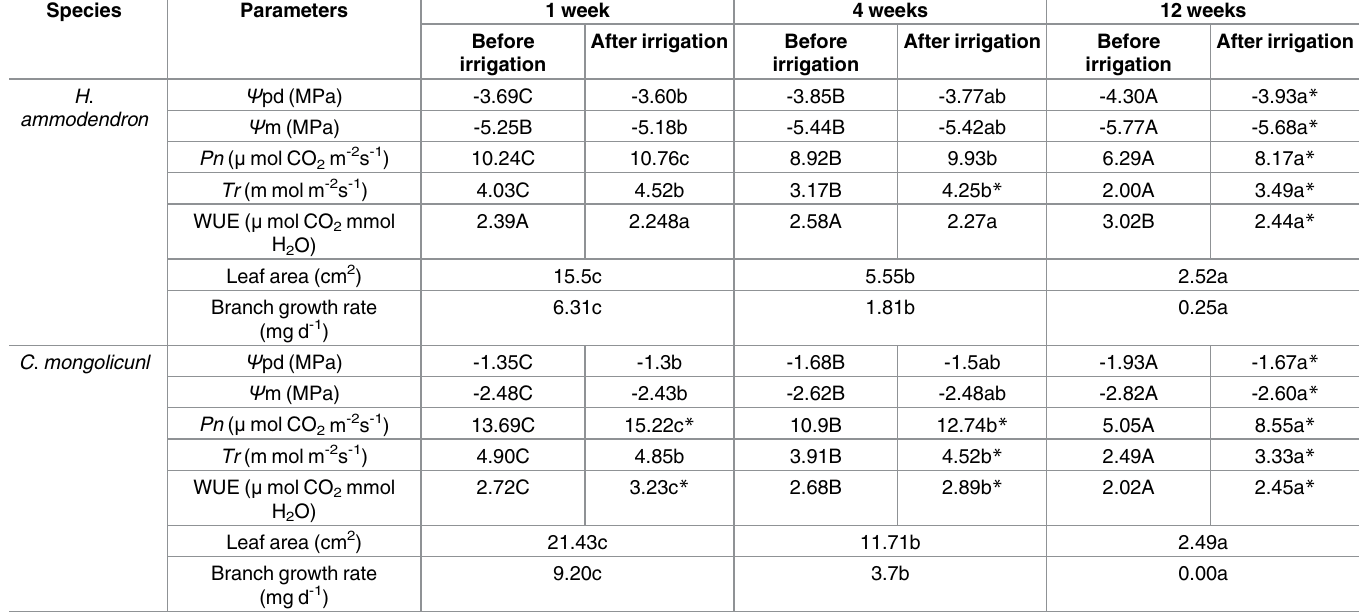
Table 3. Comparison of mean physiological and growth parameters of Haloxylon ammodendron and Calligonum mongolicunl before and afterirri- gation with intervals of 1, 4 and 12 weeks. Species